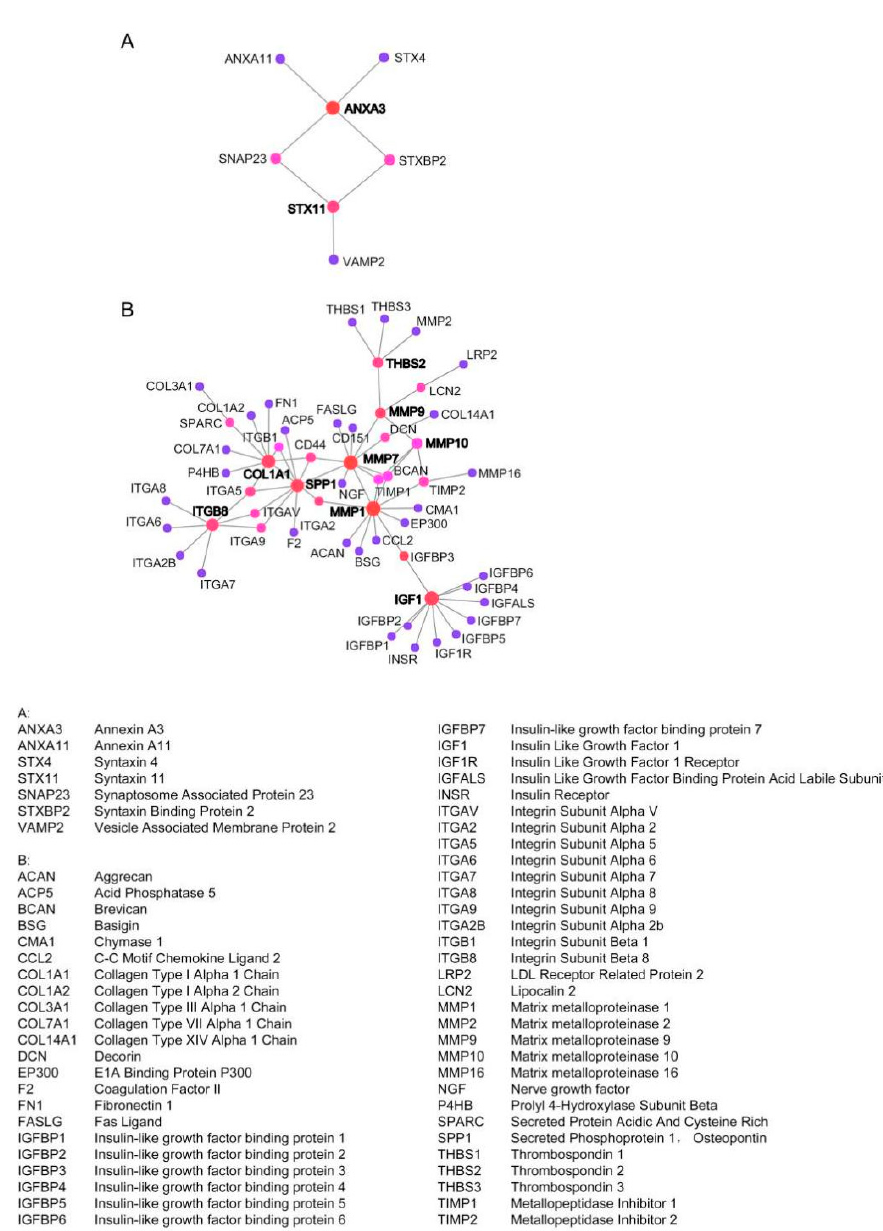
Figure 3. Protein–protein interaction (PPI) network complex and modular analysis of DEGs. ( A ) The PPI network of downregulated DEGs contains 7 nodes (genes) and 7 edges (gene–gene associations). ( B ) The PPI network of upregulated DEGs contains 56 nodes(genes) and 67 edges (gene–gene associations). Associations are meant to be specific and meaningful; genes jointly contribute to a shared function; this does not necessarily mean they are physically binding each other.